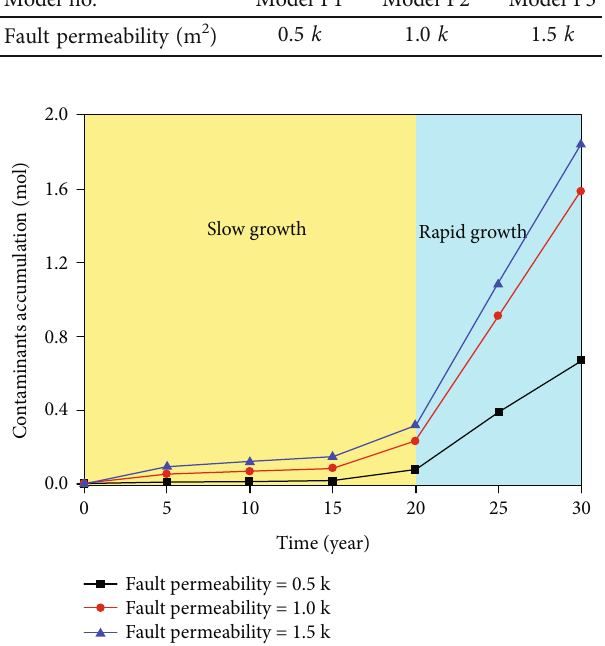
Table 5: Permeability in di ff erent models. Model no.